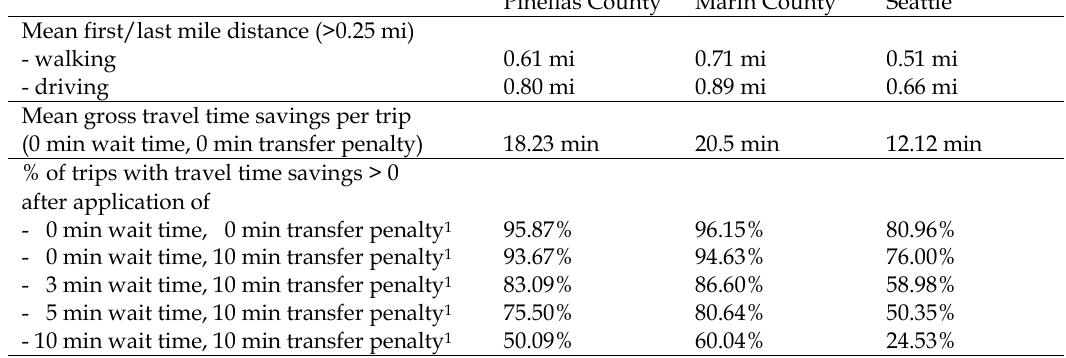
Travel time savings (walking time equivalent) after application of transfer penalties and wait